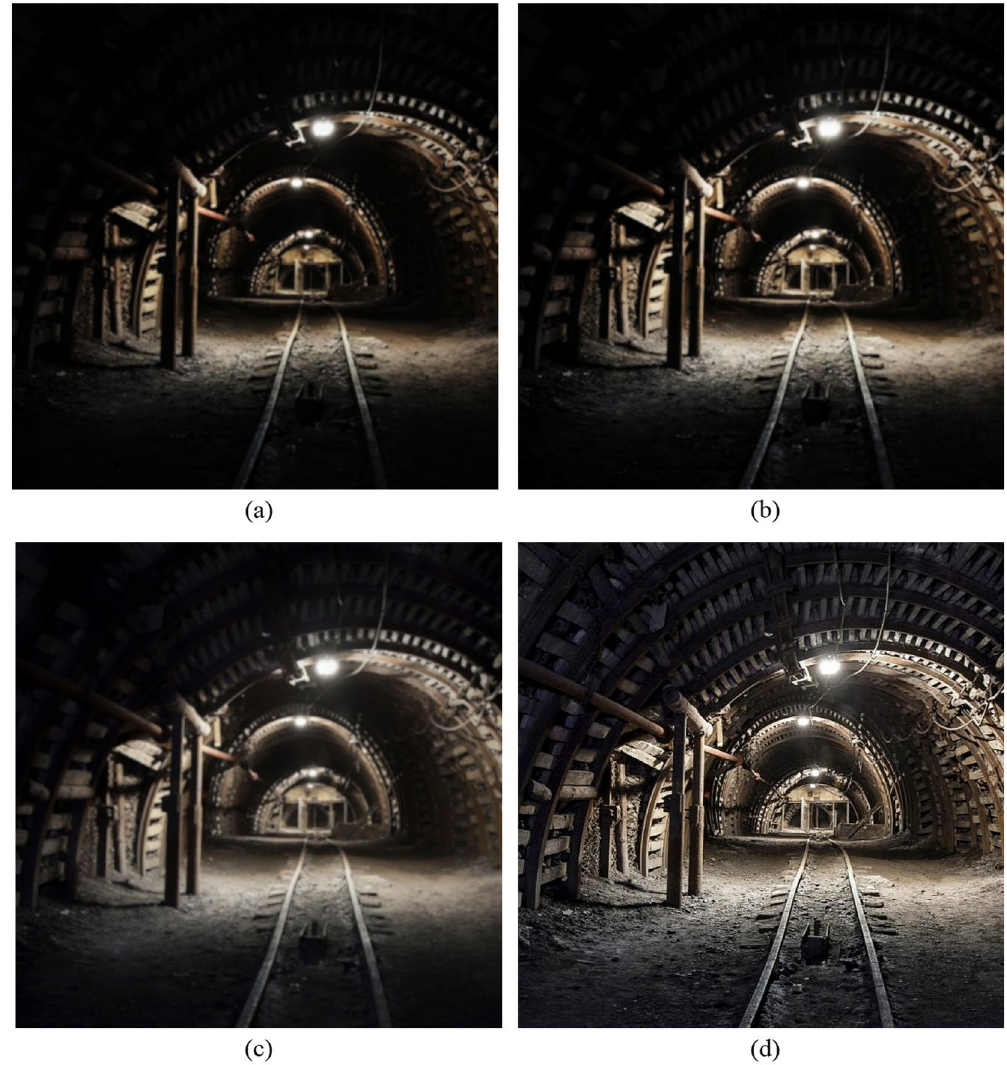
Figure 9. The enhancement effect of the three algorithms on the second set of images in the mine.